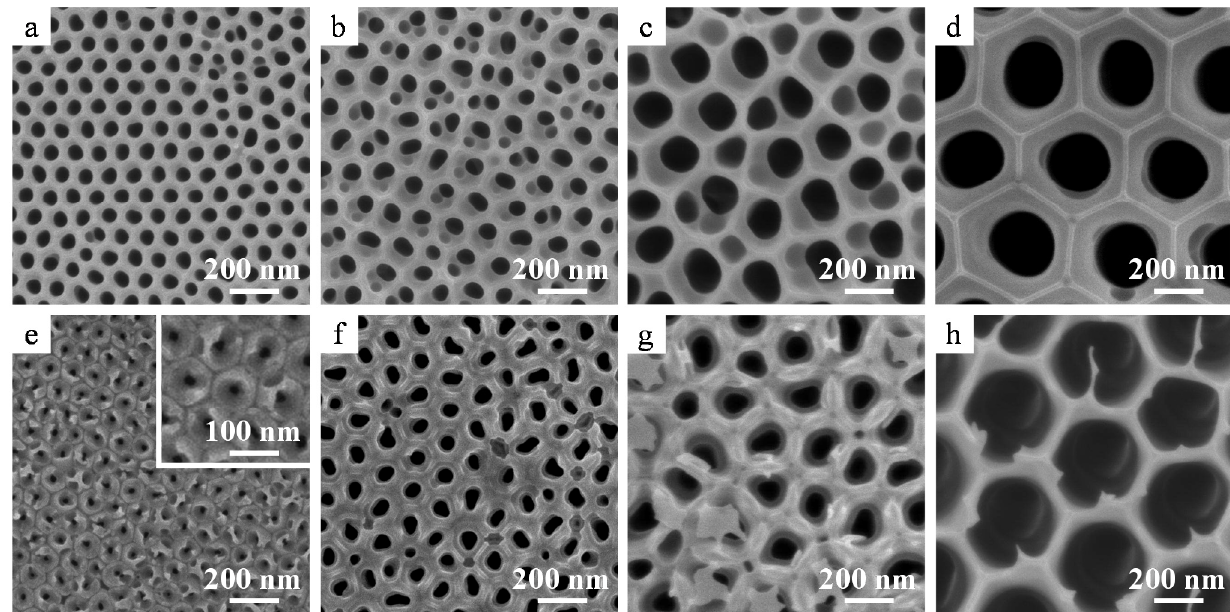
Figure 3. SEM images of ( a – d ) top and ( e – h ) rear surfaces of amorphous alumina membranes formed via anodizing at ( a , e ) 40 V, ( b , f ) 60 V, ( c , g ) 100 V, and ( d , h ) 185 V. The inset indicates a high magnification image of the rear surface. Through-hole treatment was conducted in 5 wt% phosphoric acid at 30